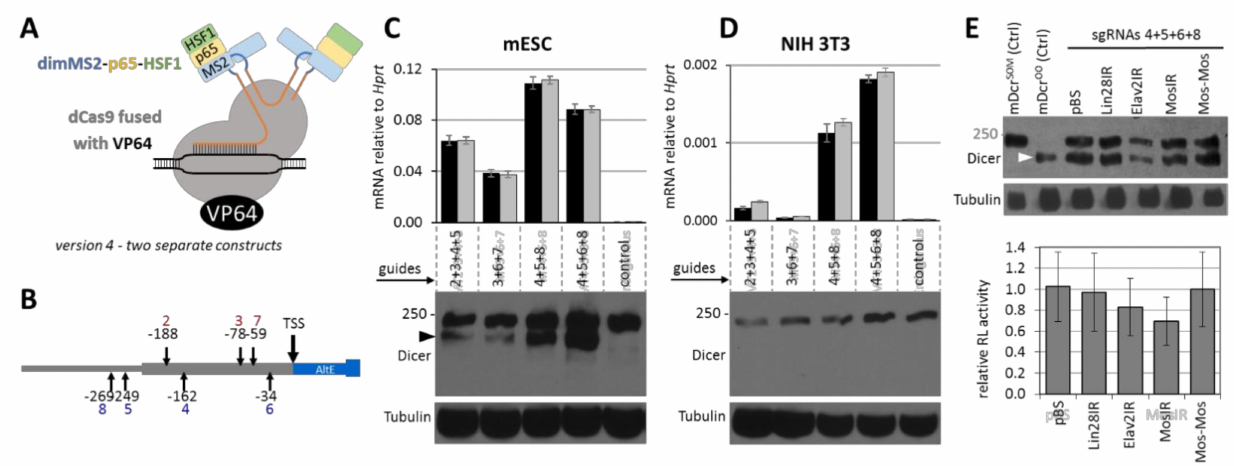
Figure 4. Transcriptional activation of Dicer O . ( A ) Schematic depiction of the finally chosen version 4. ( B ) Schematic depiction of the position of sgRNAs targeting the MTC promoter. ( C ) Activation of Dicer O with shRNA combinations in ESCs analyzed by qPCR and Western blot. Dicer O is visible as the lower band detected by the anti-Dicer antibody (depicted by black arrowhead). ( D ) Activation of Dicer O with shRNA combinations in NIH 3T3 cells analyzed by qPCR and Western blot. Dicer O was not detected. ( E ) Analysis of RNAi effects in ESCs where Dicer O expression was induced with sgRNAs. Western blot depicts activation of Dicer O in ESCs (depicted by white arrowhead). The first two Western blot lanes show control ESCs expressing either the full-length Dicer S or truncated Dicer O [14]. The graph depicts the relative activity of a Renilla luciferase reporter carrying a cognate Mos sequence as described previously [12]. Briefly, the Renilla-Mos reporter is co-transfected with a non-targeted firefly luciferase reporter and a reporter expressing dsRNA from an inverted repeat (IR). pBS and MosMos are controls not expressing dsRNA. All error bars = standard